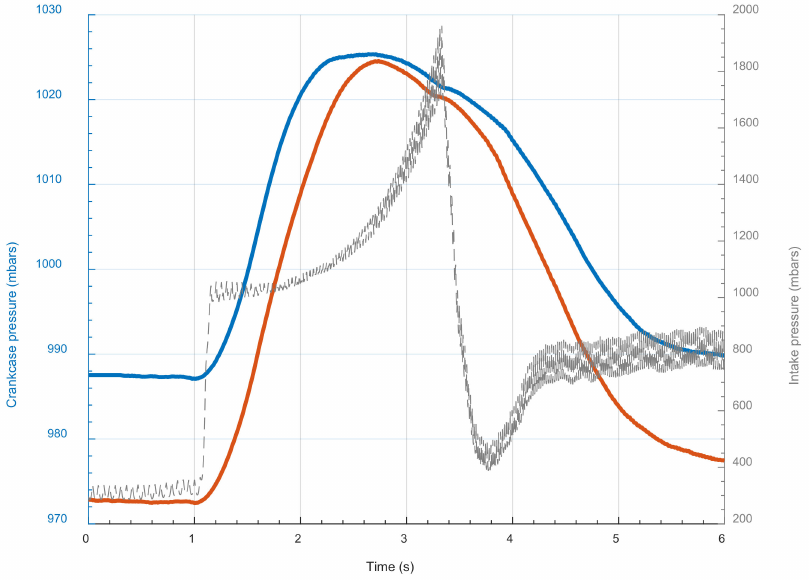
Figure 9. Evolution of the oil pan pressure and intake pressure for cases 1 and